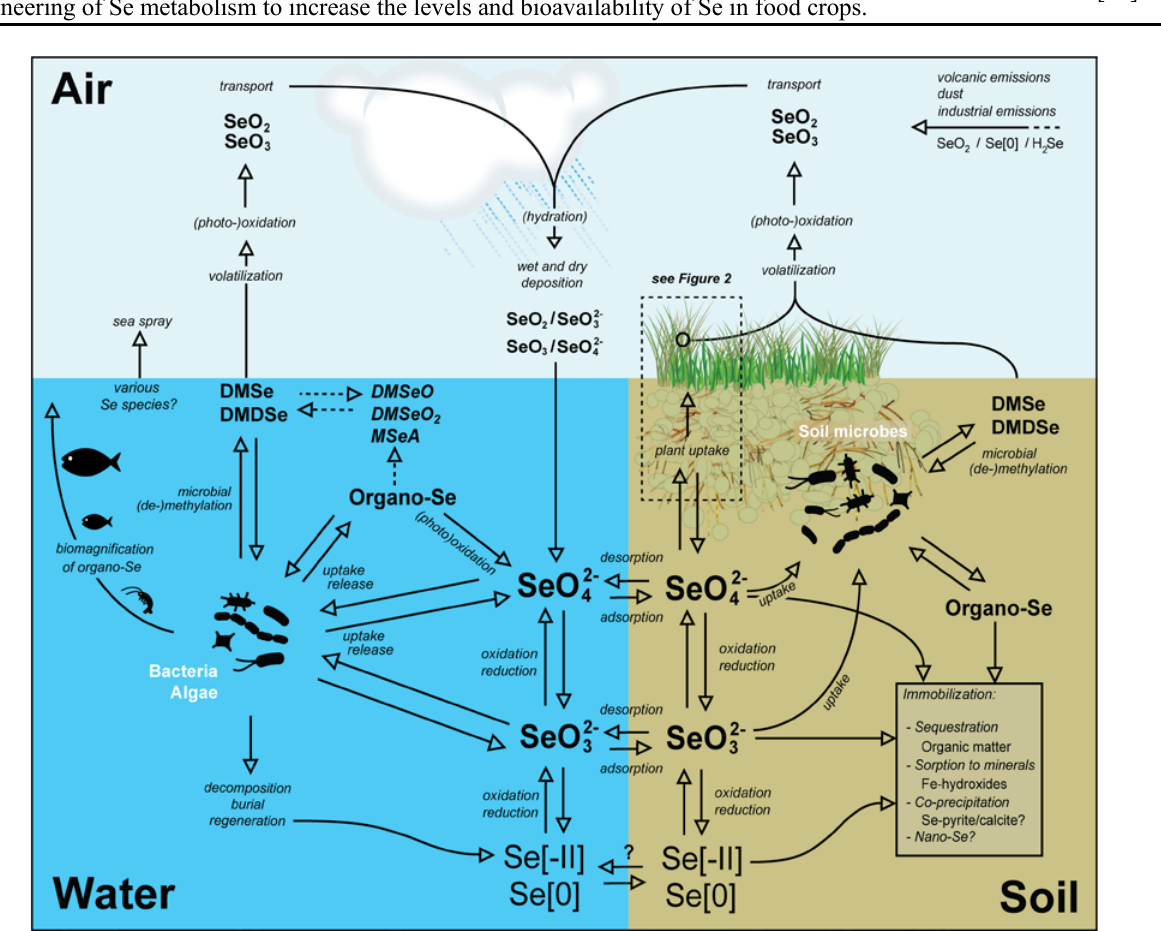
Figure 1. Overview of Se species, pathways and transformations in soil, water, atmosphere and their interfaces. Abiotic and biotic fluxes and transformations are indicated in italics at the corresponding arrows. Potential immobilization processes in soils are listed in the